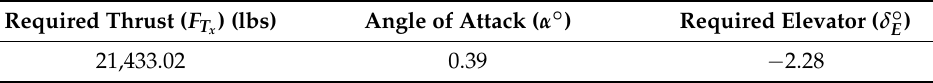
Table 2. Trim parameters of Chaka MRJ.